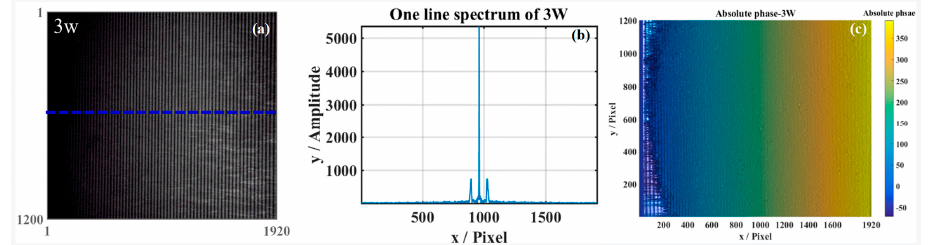
Figure 5. Test results of metal plate surface: ( a ) deformed fringe with UV light source, ( b ) distribution along the center line of Fourier spectrum of ( a ), ( c ) unwrapping phase of ( b ).